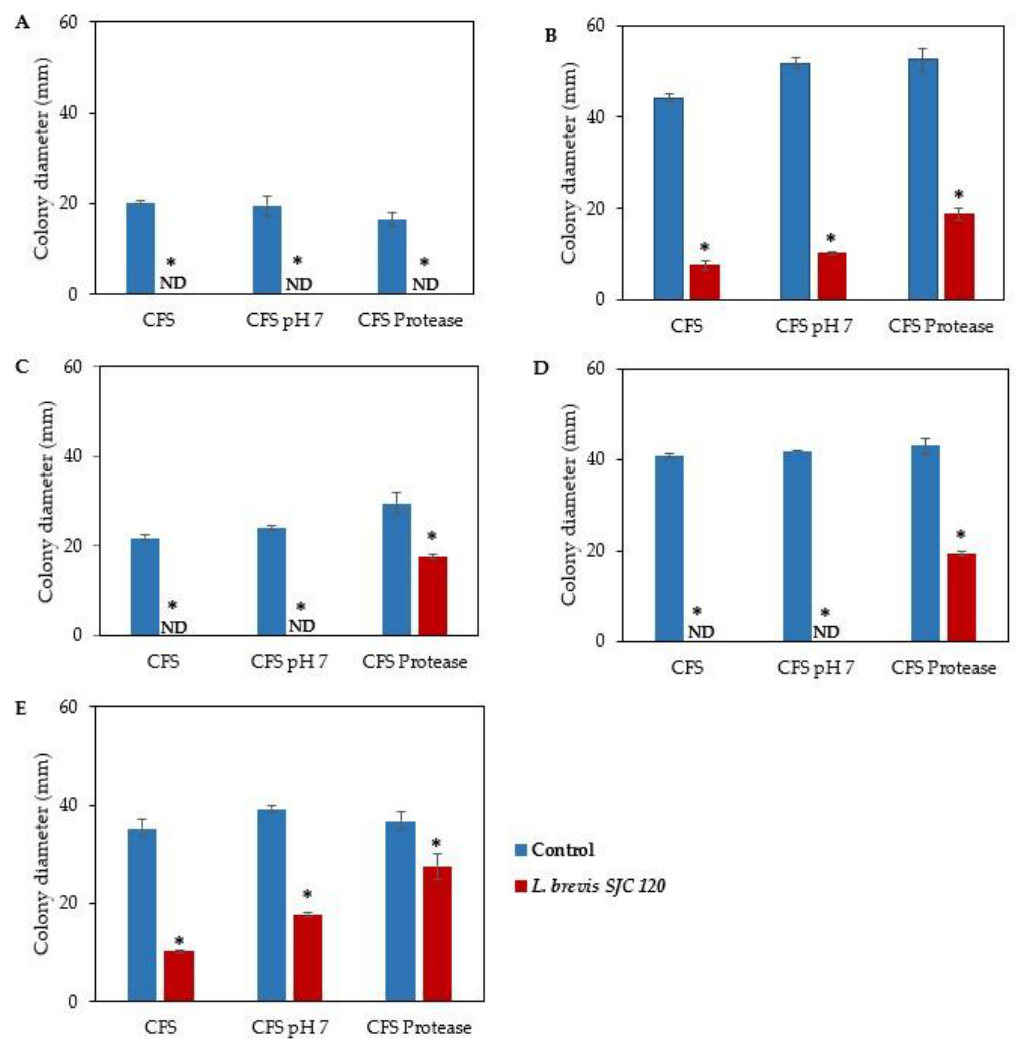
Figure 3. Effect of CFS from L. brevis SJC120 on fungal growth (mm) of ( A ) A. chevalieri , ( B ) A. flavus , ( C ) P. brevicompactum , ( D ) P. commune , and ( E ) P. nordicum . CFS: untreated CFS, CFS pH 7: neutral- ization of CFS, and CFS protease: CFS treated with protease K. Values are the mean ± SEM ( n = 3). * p < 0.05 versus control. ND: not detected (no fungal growth observed).